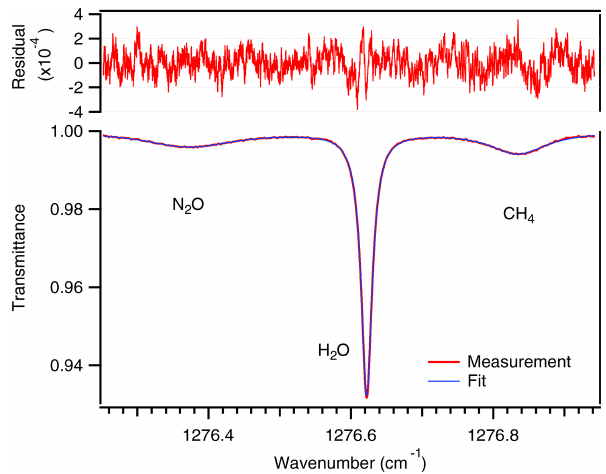
Figure 3. Measured transmission spectrum of ambient air at atmo- spheric pressure and room temperature recorded at 1Hz, i.e., aver- aged over 6000 consecutive single scans. The associated fit (Voigt profile) and the residual plot (top) indicate the high fidelity and qual- ity of the measurement. The laser frequency tuning can be extended to cover a nearby absorption line of N 2 O as